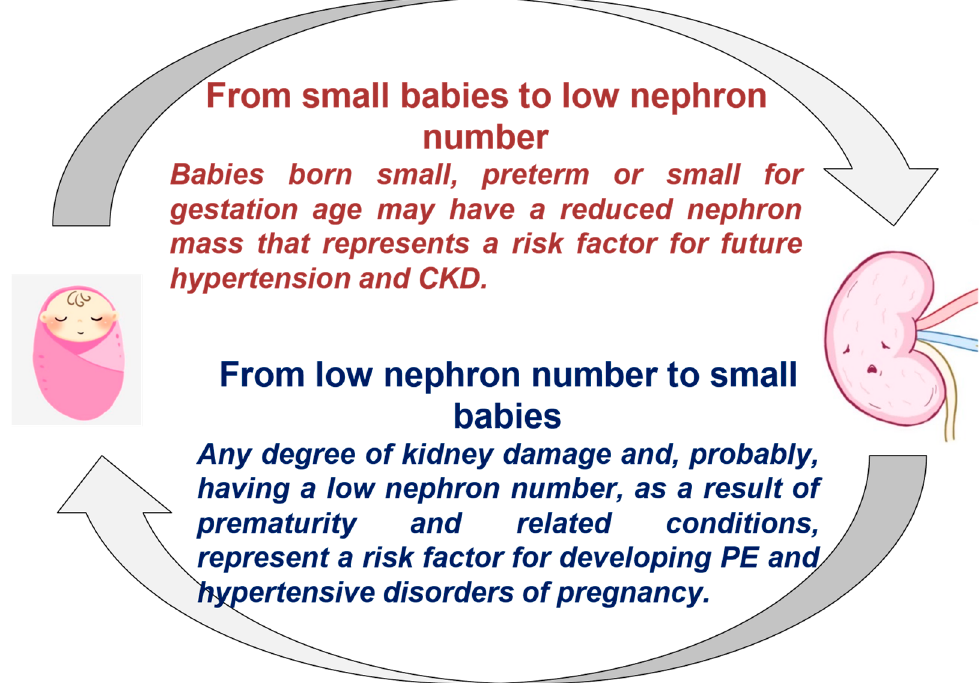
Figure 3. The vicious circle from small baby to complicated pregnancy and back to small baby. PE: preeclampsia, CKD: chronic kidney disease.